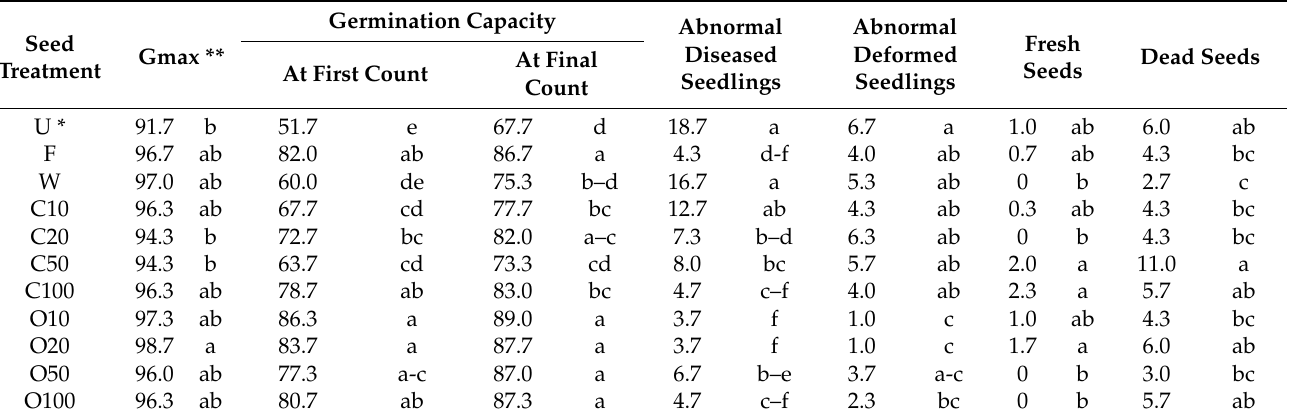
Table 1. Effects of coconut and oregano hydrolates treatment on the seed germination of onion seeds of sample I (%).